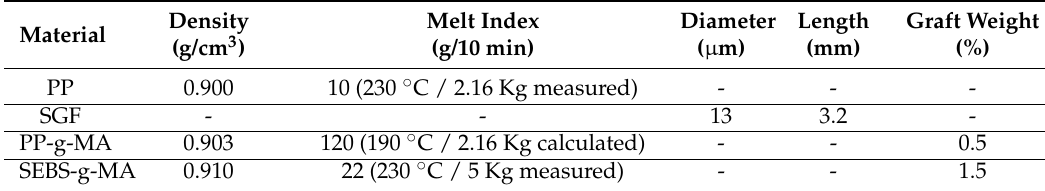
Physical properties of materials. Polypropylene, PP; Short Glass Fiber,